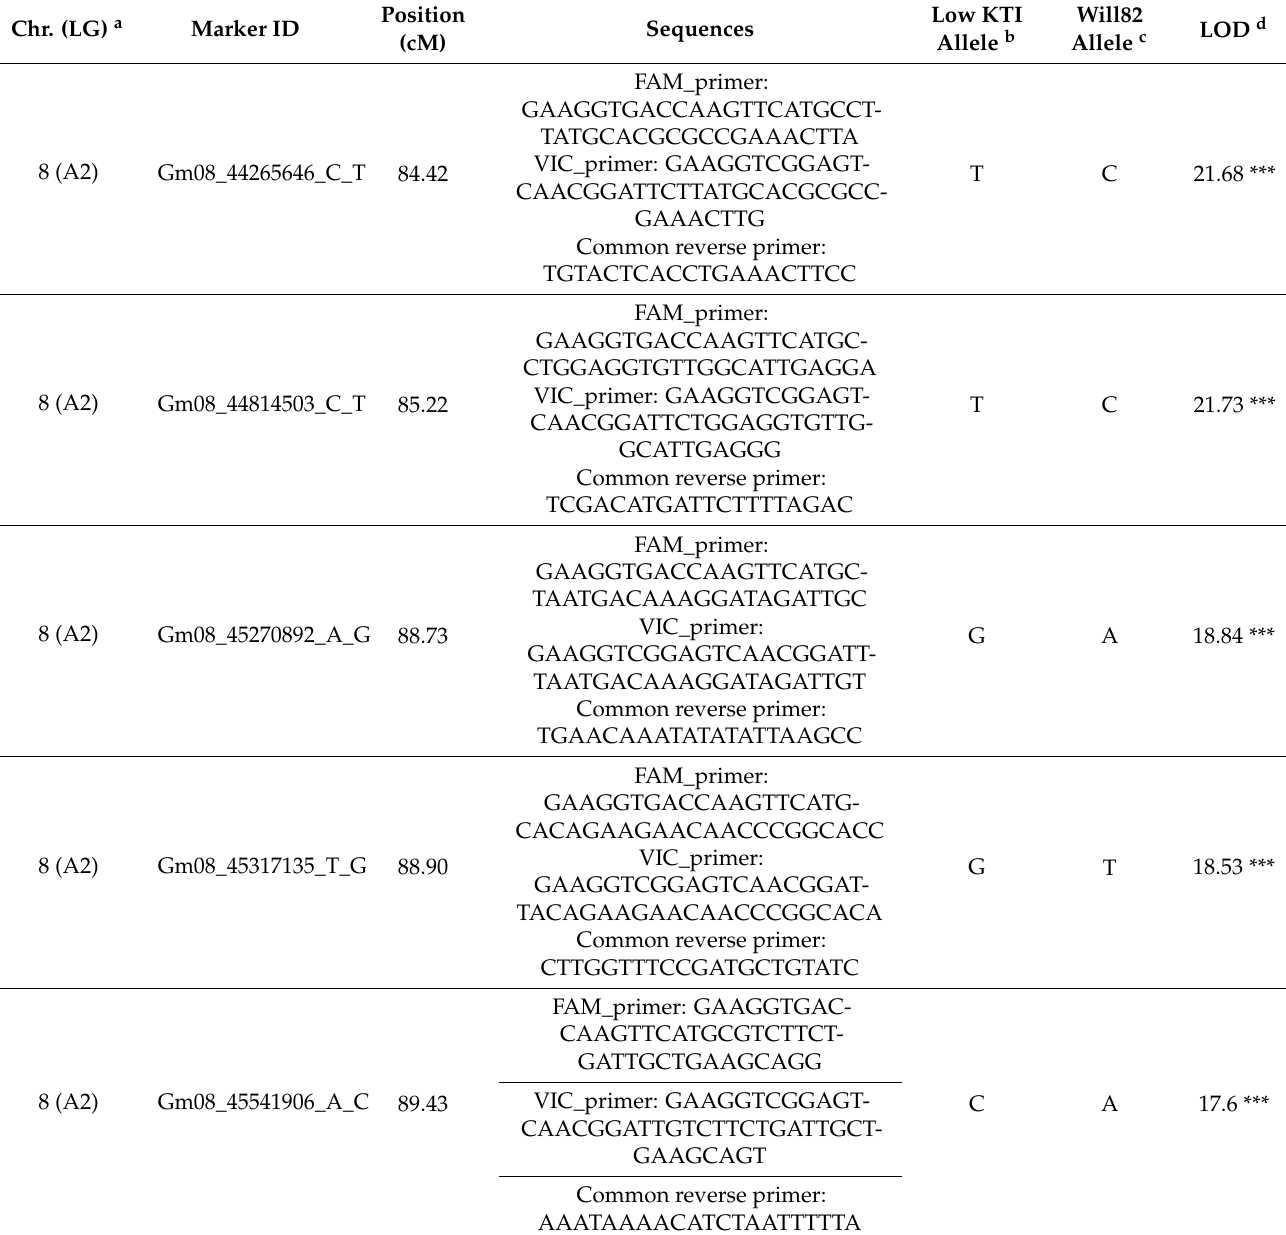
Table 7. KASP assay primers sequences significantly associated ( p < 0.0001) with concentration of KTI in the mapping population derived from Glenn x PI